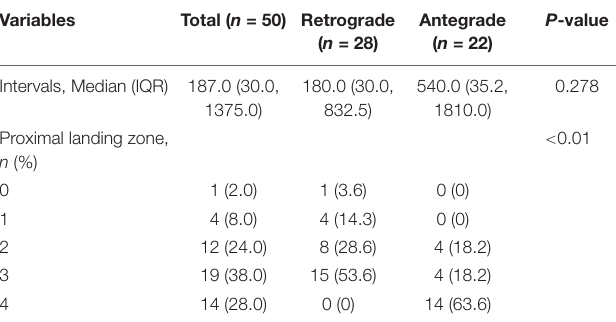
TABLE 2 | Details of previous TEVAR